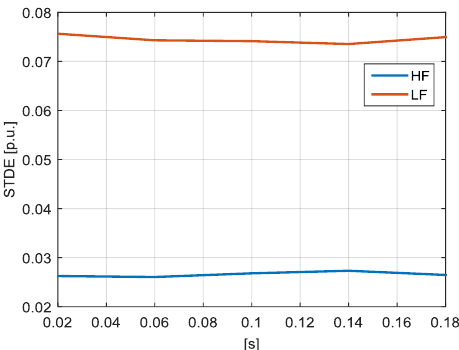
Figure 31. Case study 2: STDE at low-frequency (0 ÷ 2 kHz, red line) and at high-frequency (2 ÷ 150 kHz, blue line) obtained through STFT.